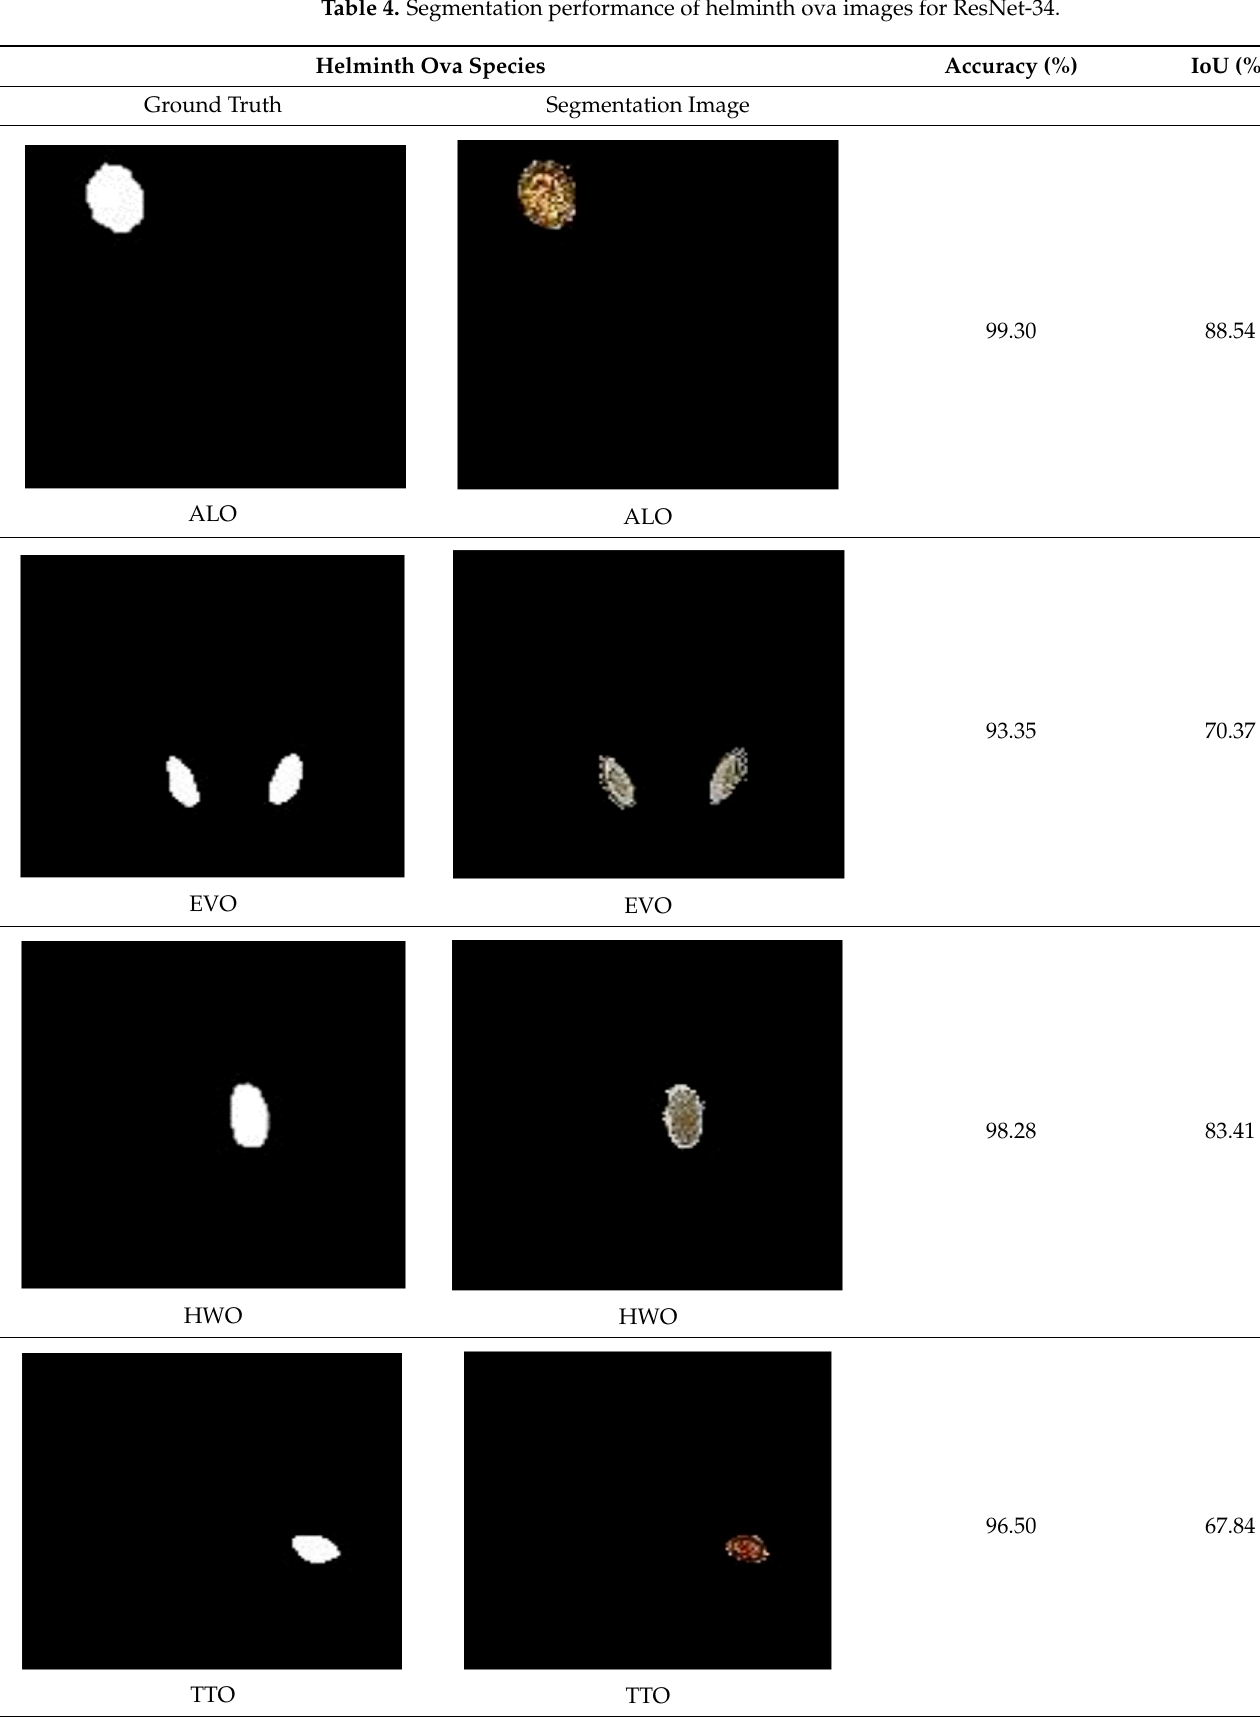
Table 4. Segmentation performance of helminth ova images for ResNet-34.